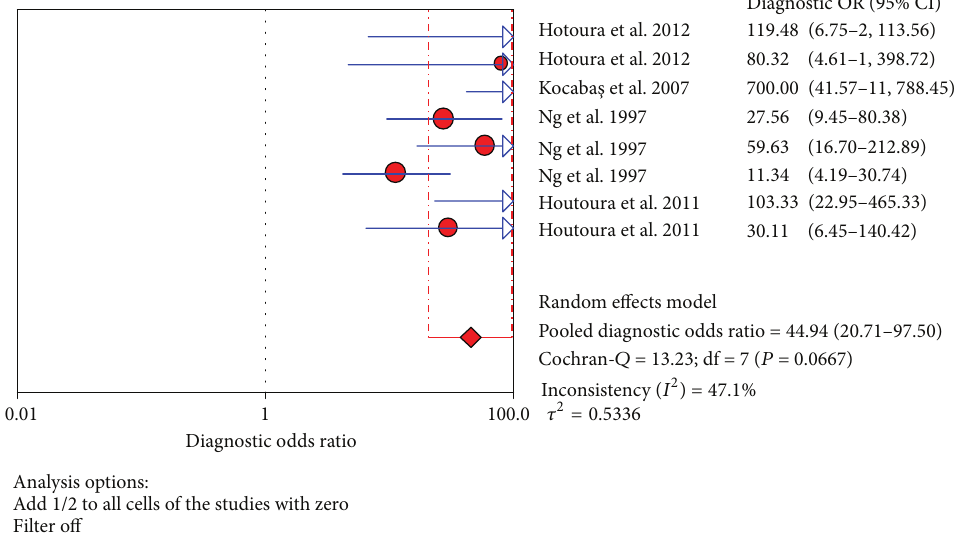
Figure 9: Forest plot for diagnostic OR of the TNF- 𝛼 test to diagnose neonatal sepsis at the LONS in the northern hemisphere.